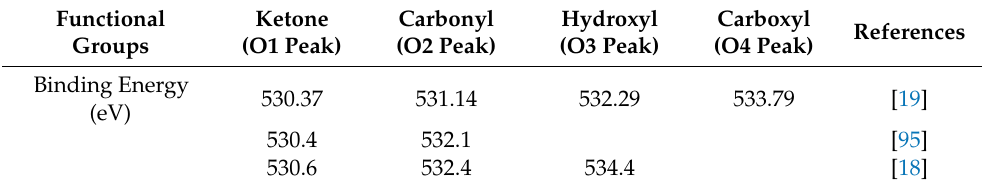
Table 6. XPS result of oxygen species of char derived from plastic